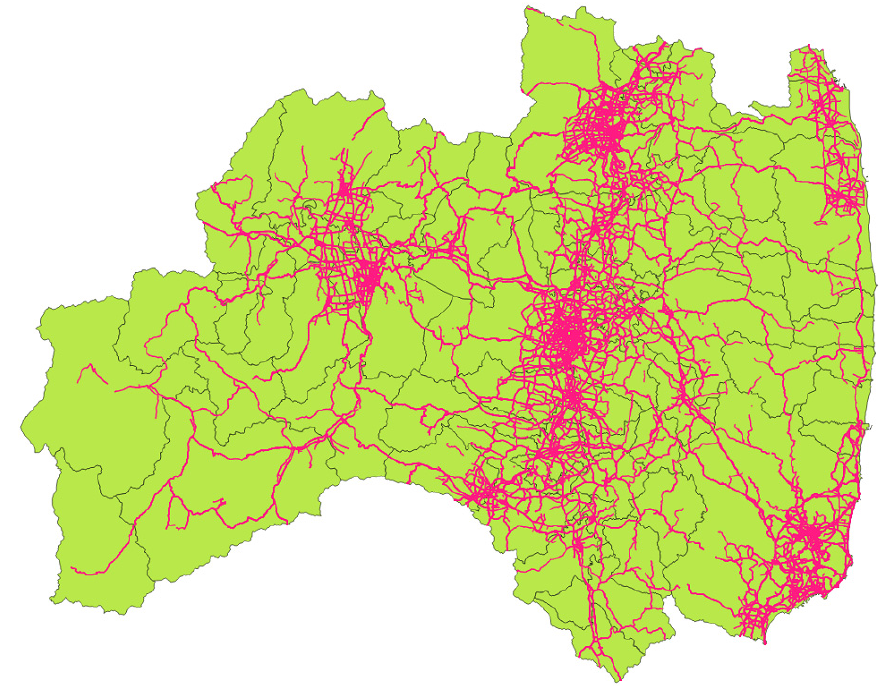
Figure 2. Vehicle tracking map of Fukushima prefecture on 30 September 2011.